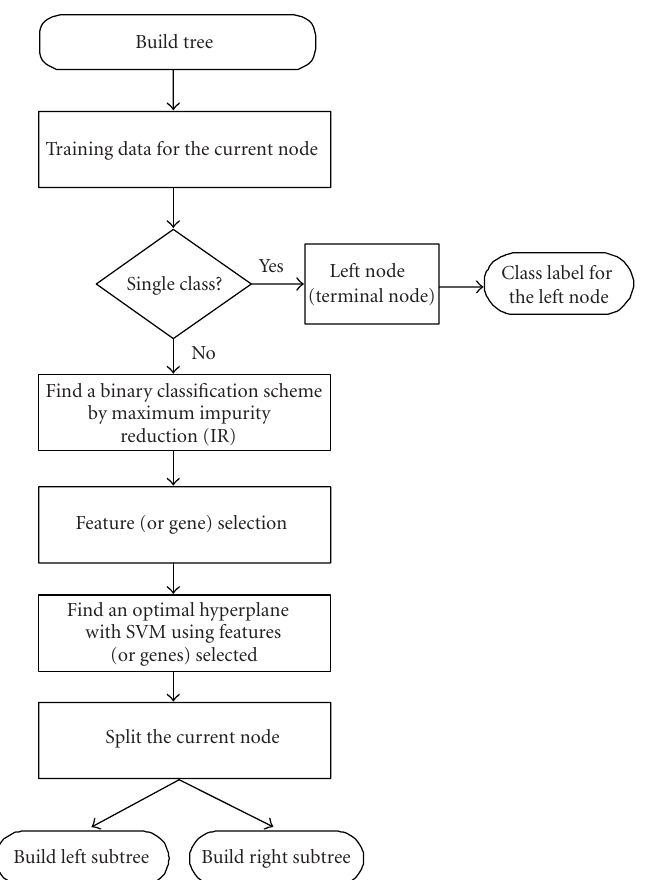
Figure 1. Binary classification tree based on SVM with gene